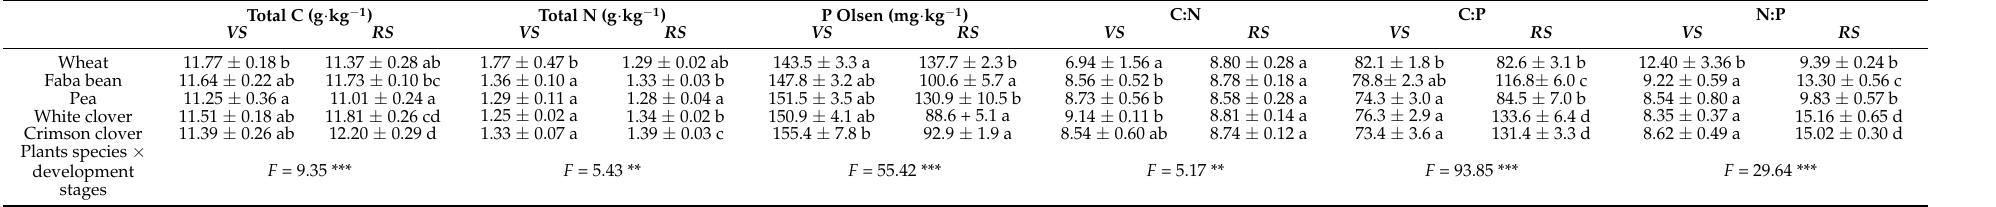
Table 1. Soil chemical characteristics under all studied plants species at the two development